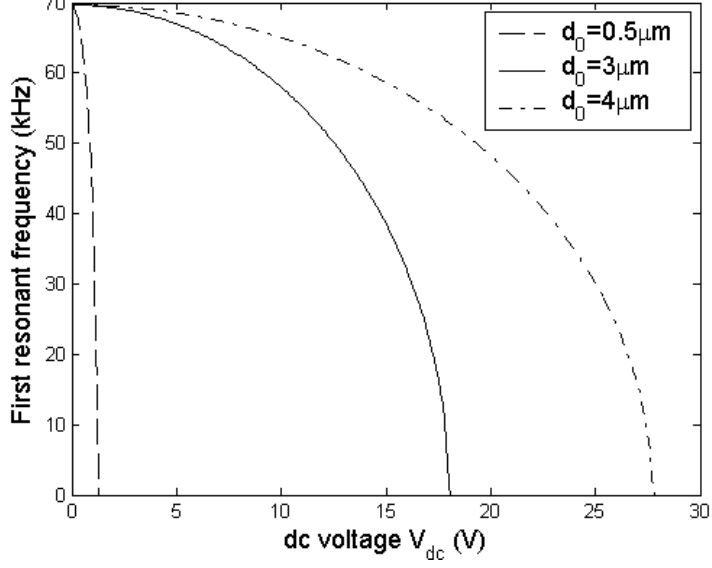
Fig. 3. Relationship between the first resonant frequency with the ac voltage at V ac = 0 V and different gaps.